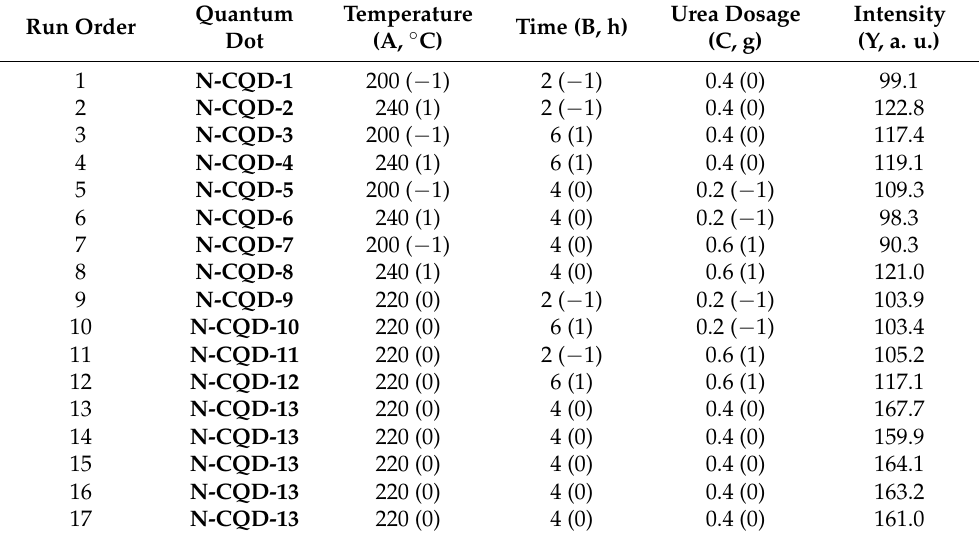
Table 4. Coded and uncoded BBD of N-CQD preparation conditions.